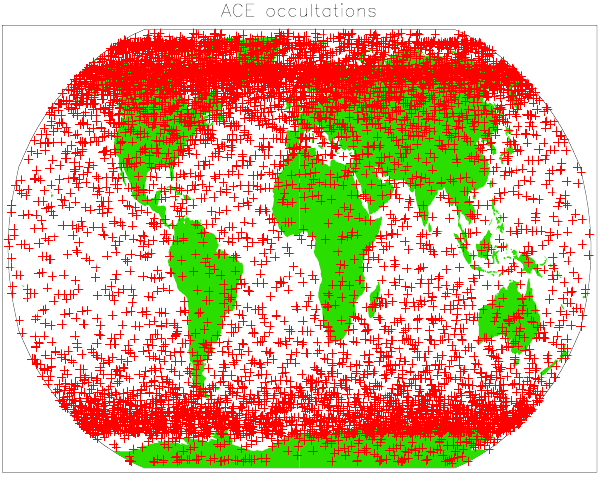
Fig. 2. ACE extravortex occultations between January 2004 and February